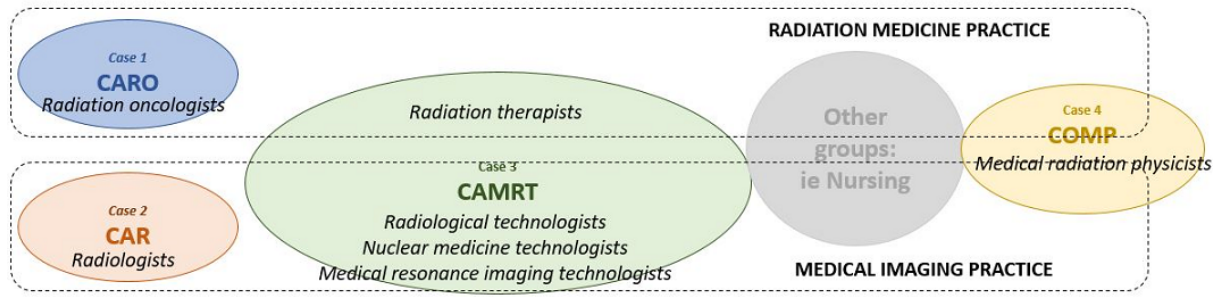
Figure 1. Relational case and context. CAMRT: Canadian Association of Medical Radiation Technologists; CAR: Canadian Association of Radiologists; CARO: Canadian Association of Radiation Oncology; COMP: Canadian Organization of Medical